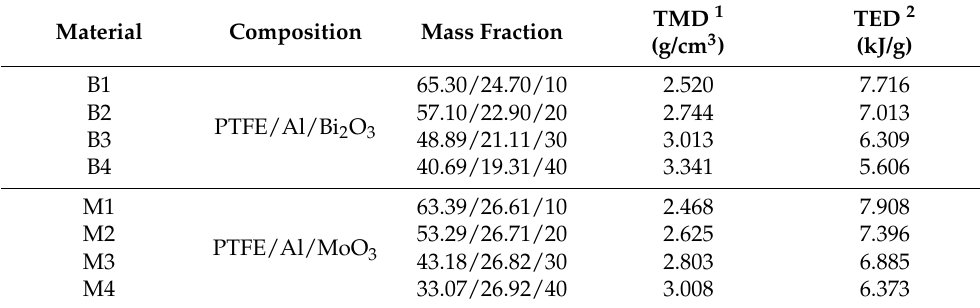
Table 2. Fundamental information of samples.